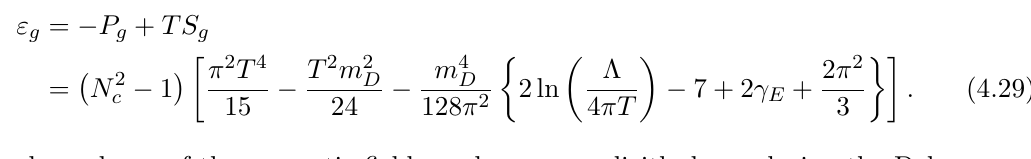
Figure 6 . The variation of energy density with temperature at di(cid:11)erent magnetic (cid:12)elds. and the gluon contribution is given